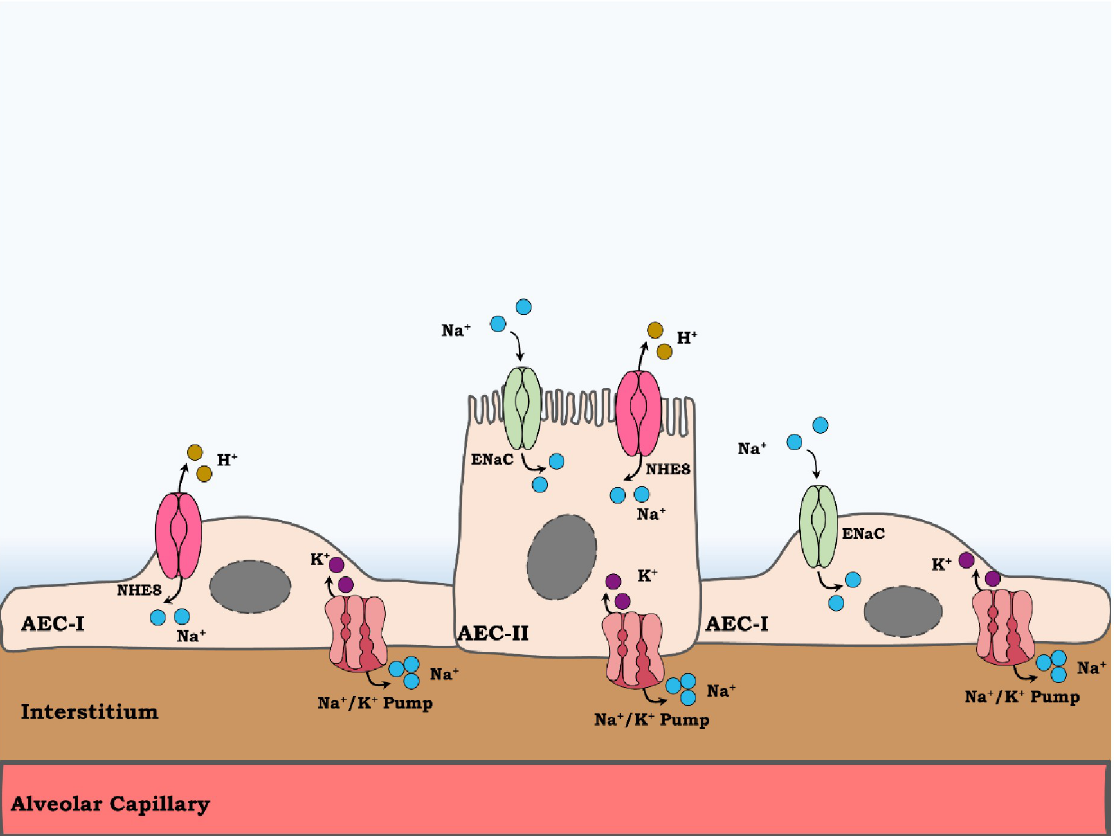
Fig 5. A schematic illustration of NHE8 role in sodium vectorial transport. NHE8 may be located to Alveolar epithelial cells type I (AECI) and II (ACEII), where in the latter it is localized to the apical membrane. By exchanging extracellular Na + with intracellular H + , NHE8 contribute to Na + vectorial transport along with epithelial sodium channel (ENaC). The entered sodium then is pumped out of alveolar cells by Na + , K + ATpase pump. Sodium transport from alveolar space to the interstitium is accompanied by water movement and so edema